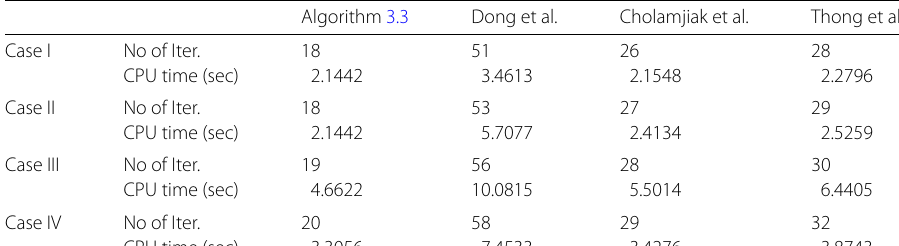
Table 1 Computation result for Example 4.1